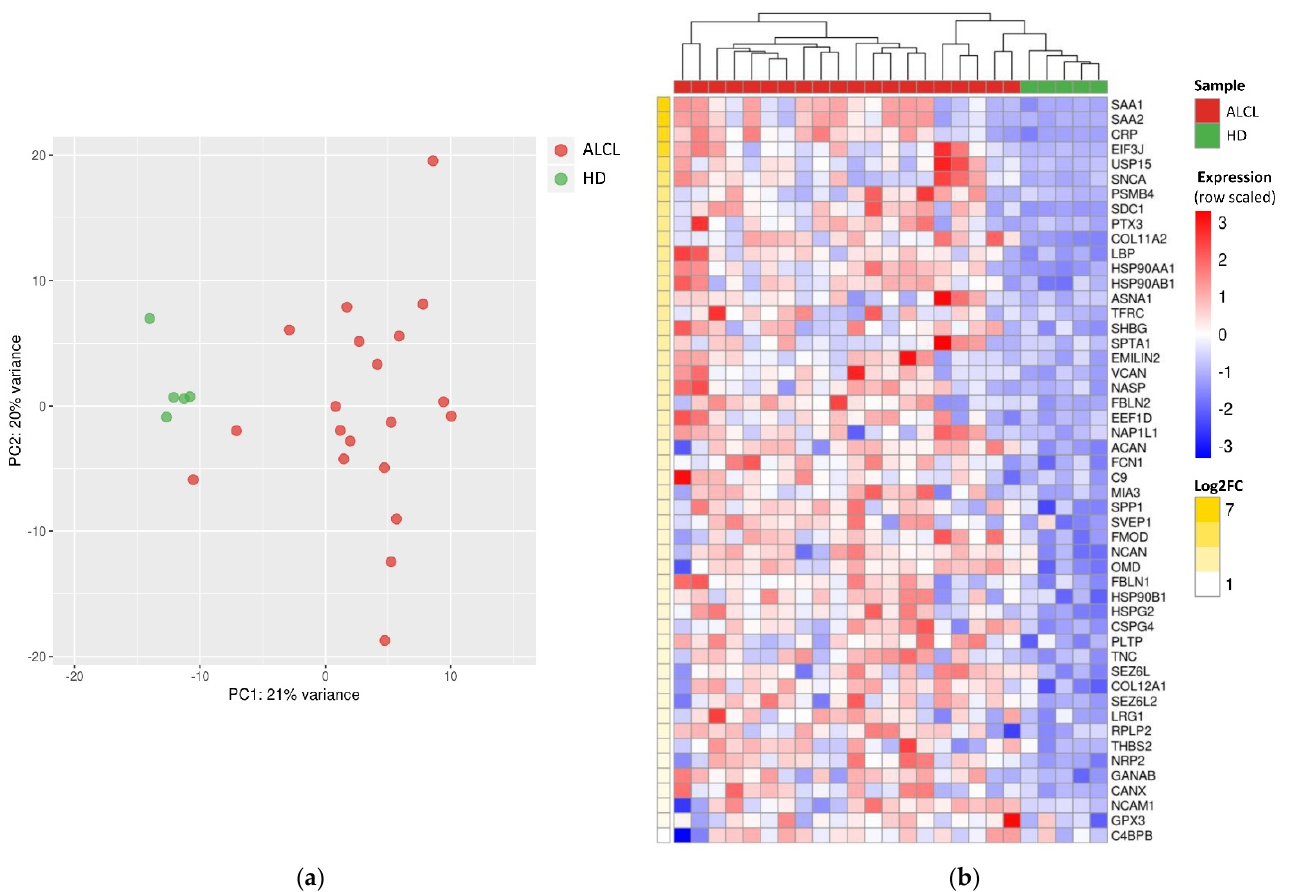
Figure 2. Differentially abundant proteins in S-EVs from ALCL samples and healthy donors. ( a ) Principal component analysis performed on abundance levels of 277 identified proteins distinguishes ALCL from healthy donor (HD) S-EVs. ( b ) Heatmap of the 50 proteins overrepresented in ALCL S-EVs, ordered by decreasing log 2 fold change (LFC). Unsupervised hierarchical clustering revealed that ALCL S-EV samples have a unique protein expression profile, distinct from HD.